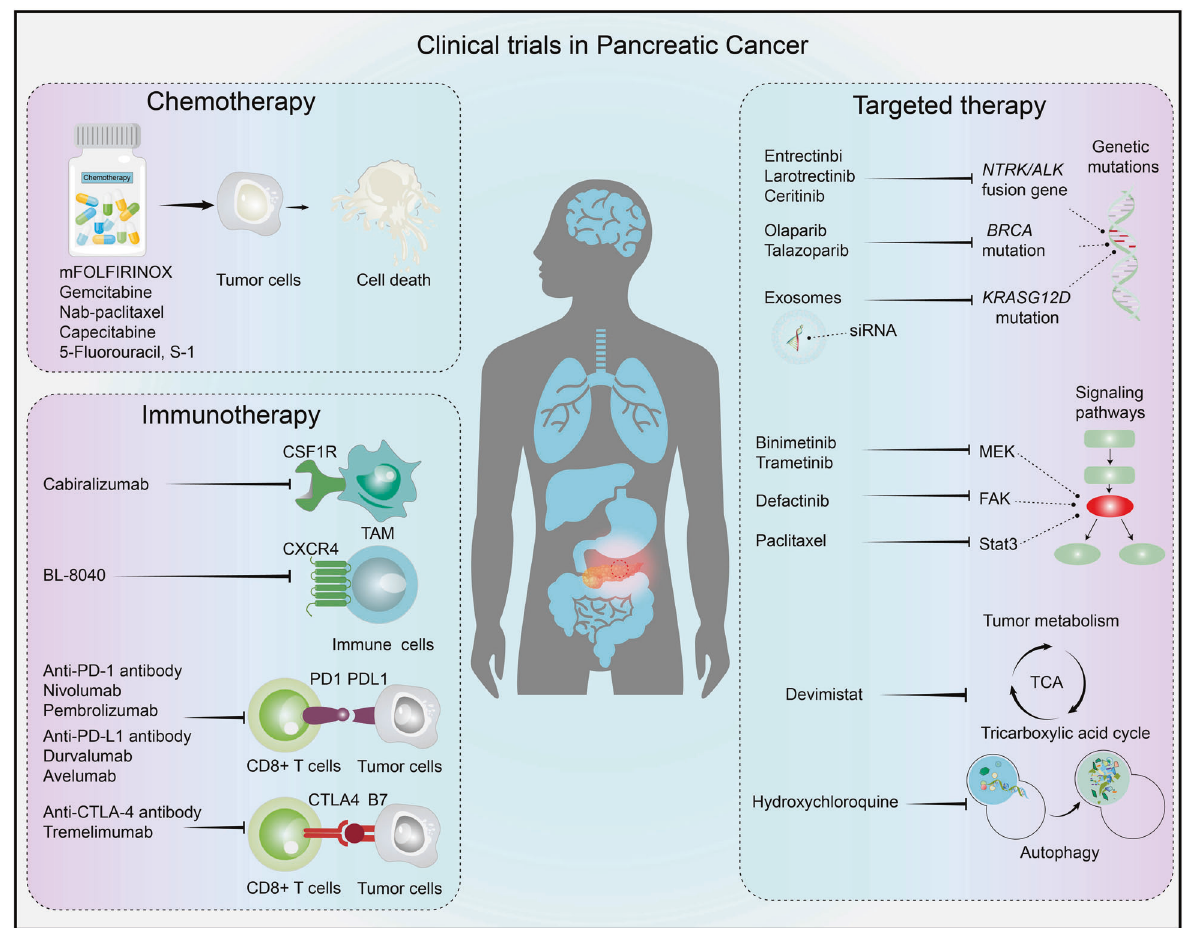
Fig. 4 Current clinical strategies in pancreatic cancer. For patients with pancreatic cancer, the primary clinical strategies rely on chemotherapy, whereas novel therapeutic agents targeting DNA repair, gene mutations, tumor metabolism, tumor microenvironments, or immune checkpoints might improve their prognosis. Currently, increasing interest has emerged in combined chemotherapy and immunotherapy or targeted